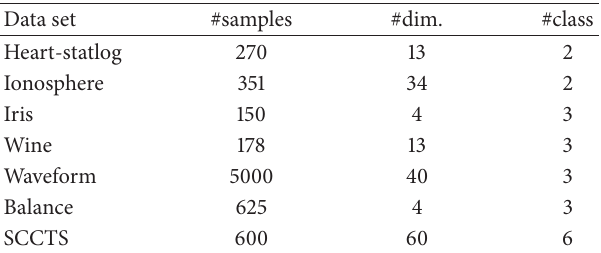
Table 1: Specification of benchmark